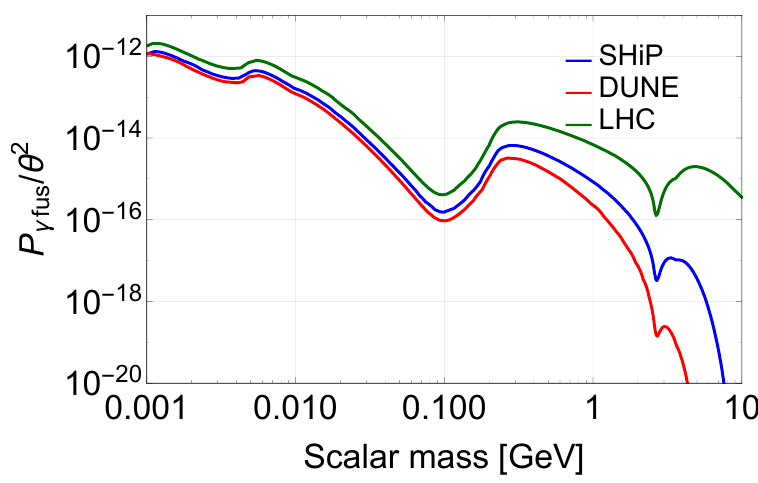
Figure 22 . The production probabilities of the scalar in photon fusion process versus the scalar mass. We consider Mo nucleus ( Z = 42, A =